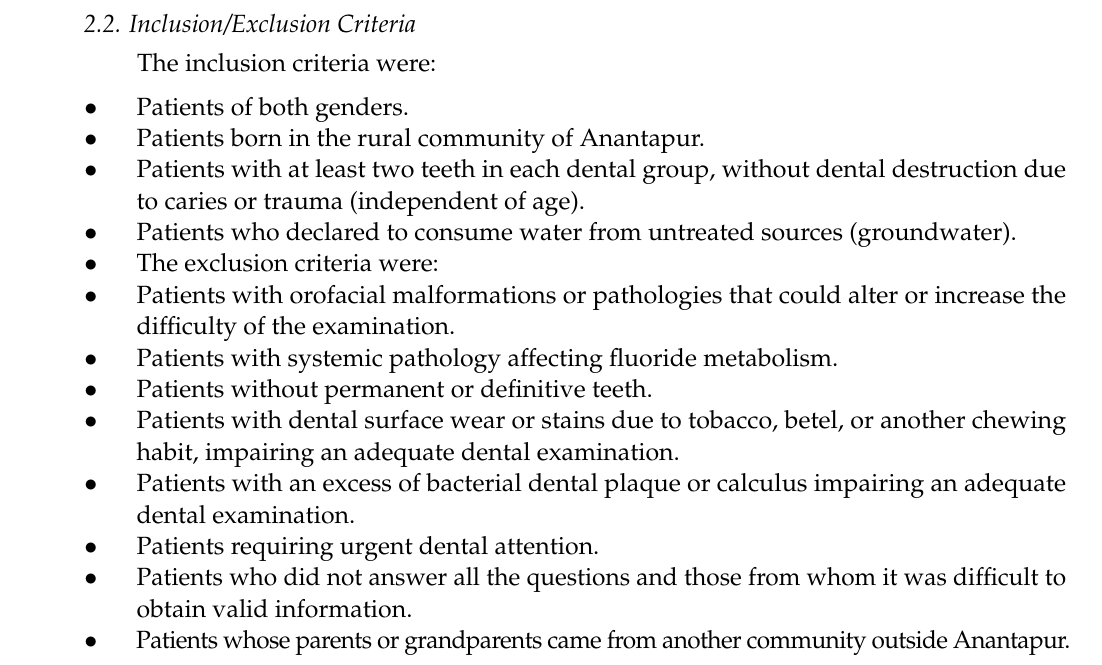
Figure 1. The 13 rural communities of Anantapur visited by the dental brigades included in the study (remarked). Images modified from Google Maps.